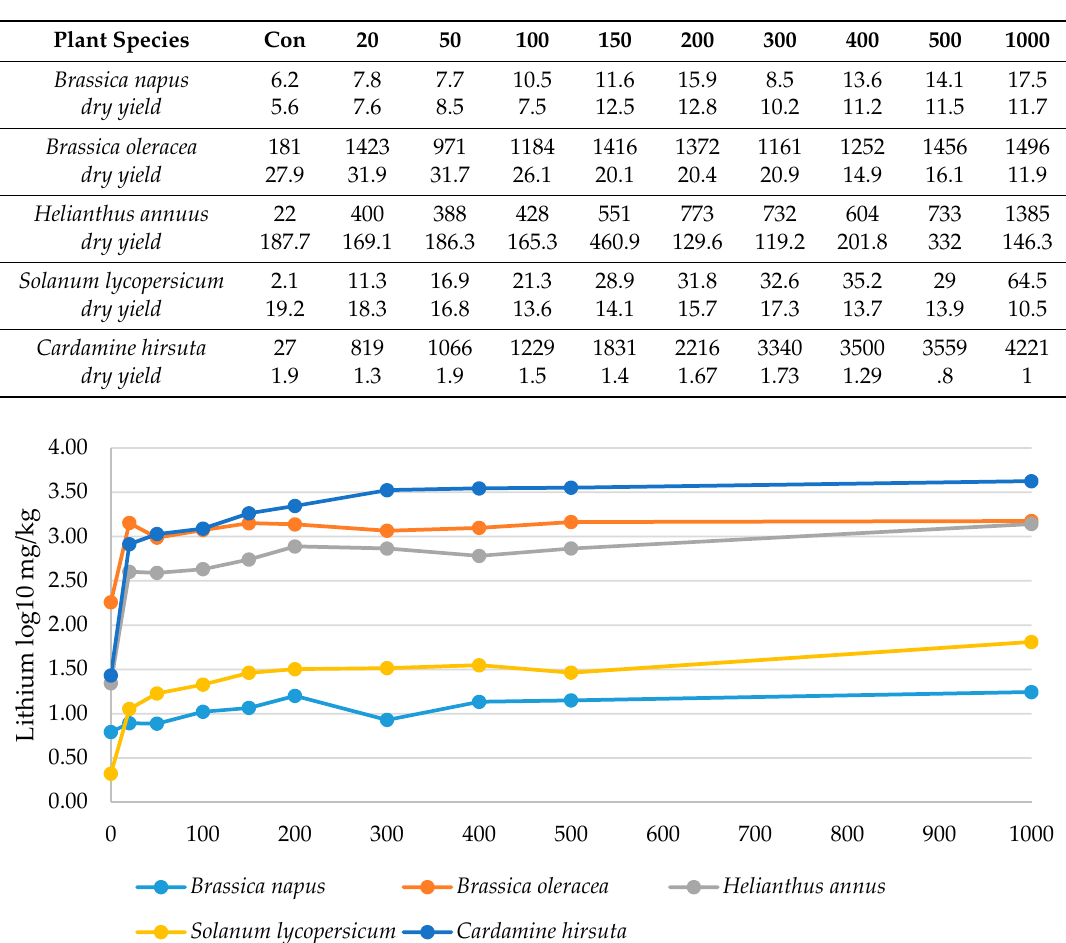
Figure 1. x ̅ Li concentrations in leaves of 5 species ( Brassica napus, Brassica oleracea, Helianthus annuus, Solanum lycopersicum , and Cardamine hirsuta). Y-axis, logarithmic transformed mg/kg Li data. X-axis, Li soil amendments, (N = 468 plants) (Units = mg/kg).